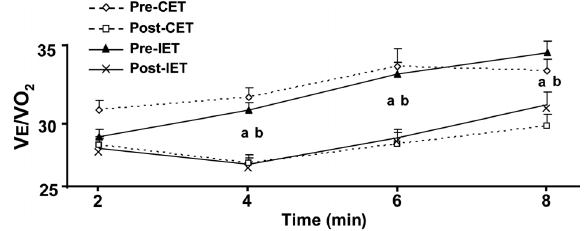
Figure 2. Ventilatory equivalent ratios for oxygen (VE/VO 2 ) at baseline (Pre), and after 3 months (Post) of continuous exercise training (CET) and interval exercise training (IET), in patients with coronary artery disease. a P o 0.05, compared to pre-CET; b P o 0.05, compared to pre-IET (two-way